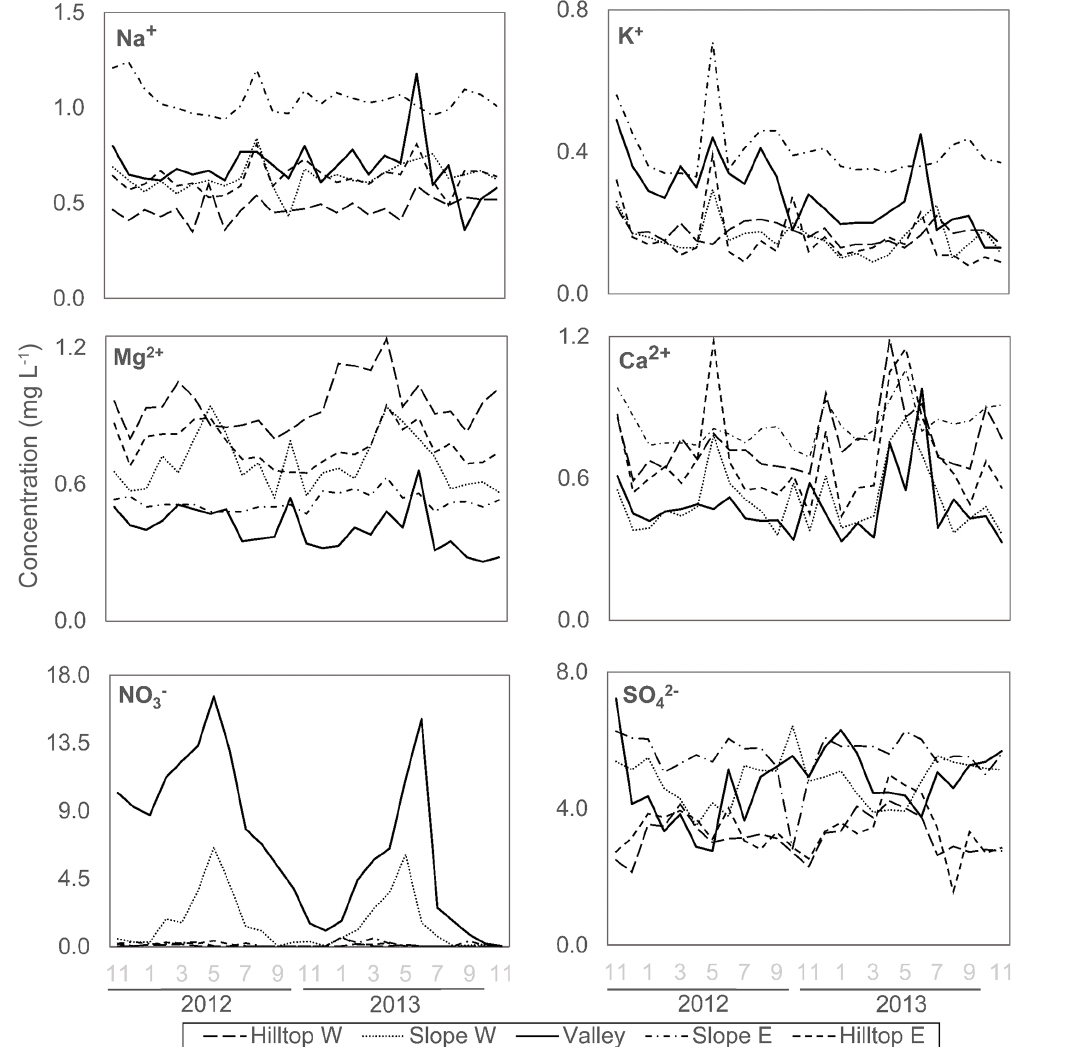
Figure 3. Spatially resolved, time-series soil solution concentration values of base cations, sulfate and nitrate at 50cm depth. The x axis shows months and hydrological